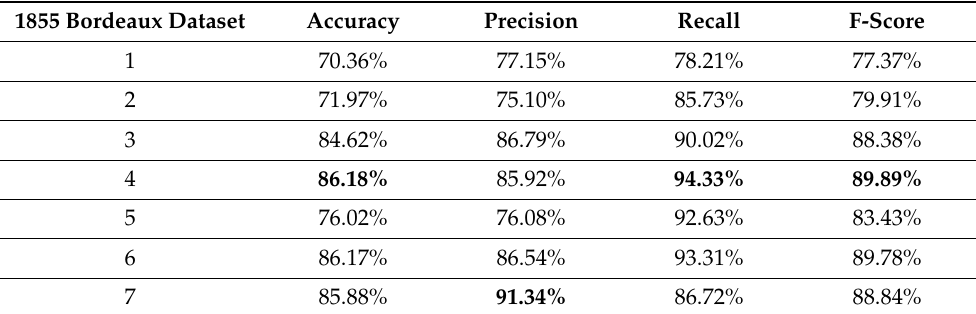
Table 5. Accuracy, precision, recall, and F-score with Naïve Bayes classifier in the 1855 Bordeaux datasets. The highest results in each column are marked in